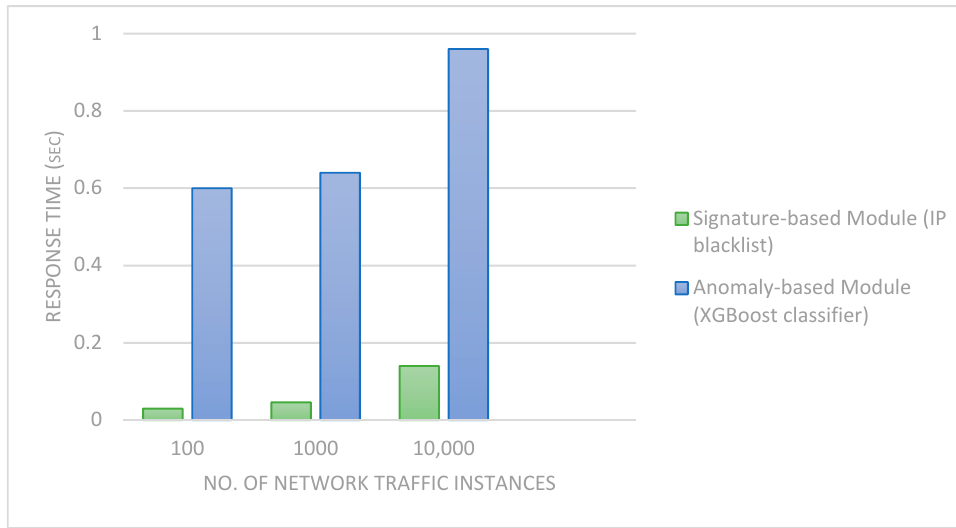
Figure 6. SHAP summary plot.